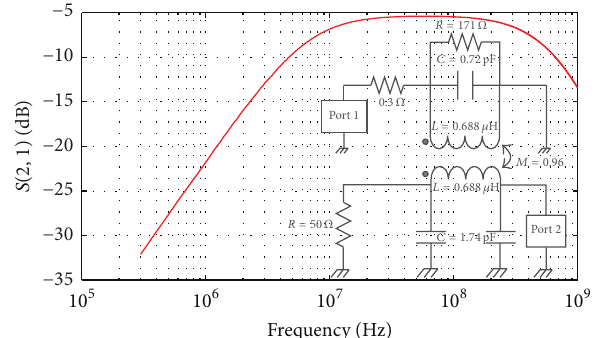
Figure 9: Insertion loss and equivalent circuit model of the BCI probe.